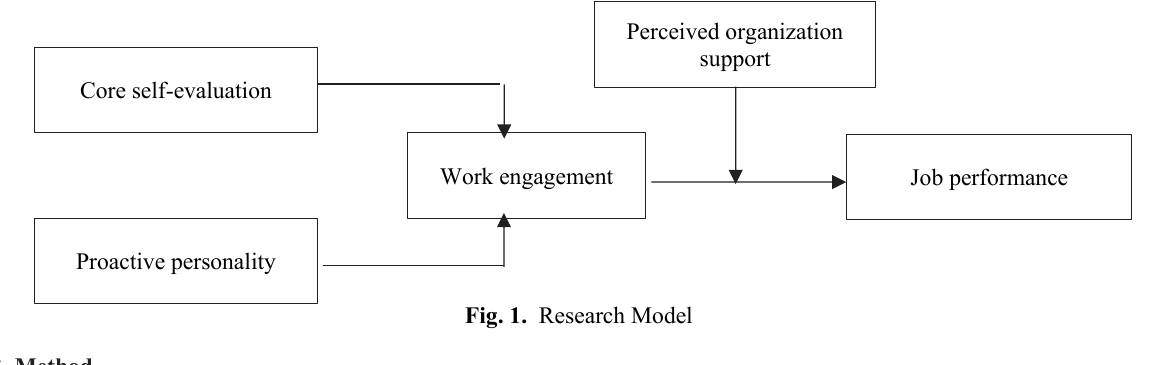
Fig. 1. Research Model